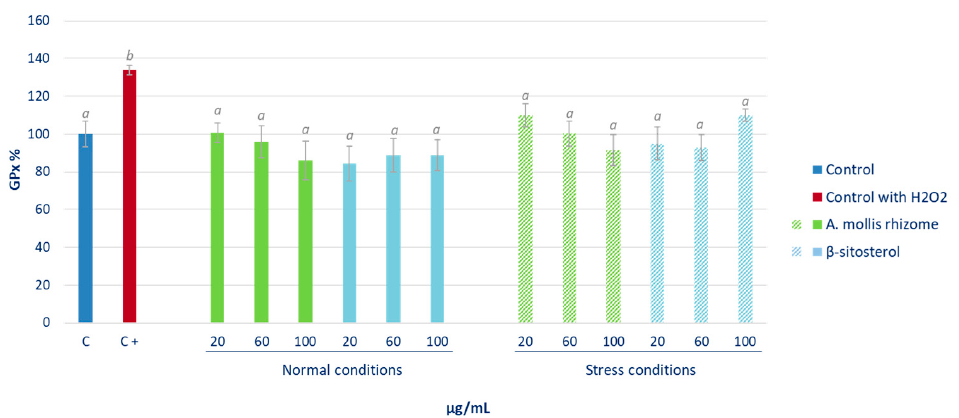
Figure 6. Effect of Acanthus rhizome extract and β -sitosterol ( µ g/mL) on glutathione peroxidase (GPx) activity. The percentage of GPx activity with respect to non-stressed control cells is represented. The results are expressed as mean ± SD ( n = 3). Different letters indicate significant differences (ANOVA-Test, Bonferroni p < 0.05).